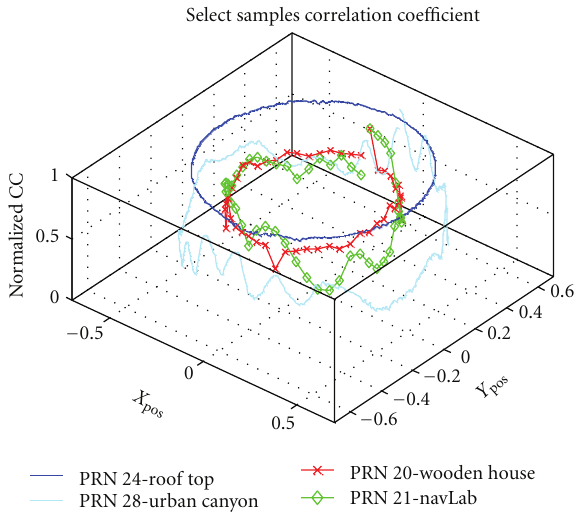
Figure 12: Correlation coe ffi cient measurements in di ff erent envi-